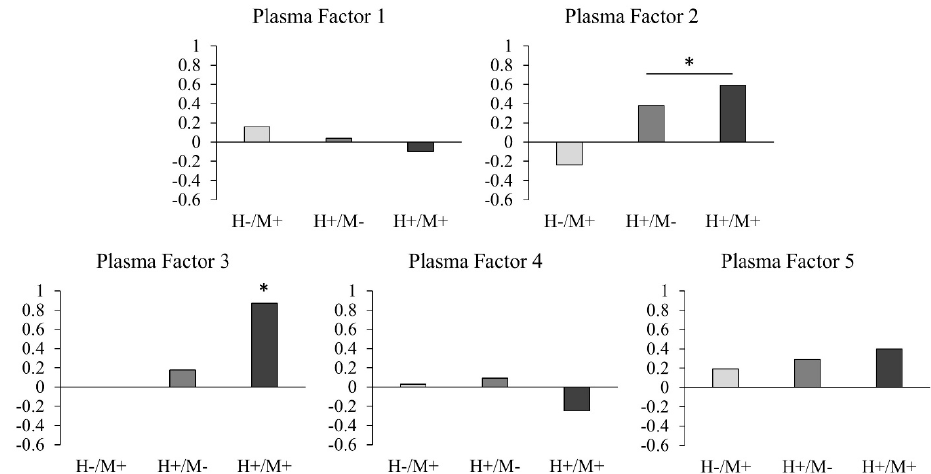
Figure 1. Effect sizes of each group compared to the HIV-/METH- group for the plasma factors. Effect sizes (using Cohen’s d) were calculated for the HIV-/METH+, HIV+/METH-, and HIV+/METH+ group compared to the HIV-/METH- group for each factor. * Significant main effect of HIV for Plasma Factor 2 (i.e., HIV+ groups > HIV- groups) and significant group differences for HIV+/METH+ group for Plasma Factor 3 (i.e., HIV+/METH+ group > all other groups).